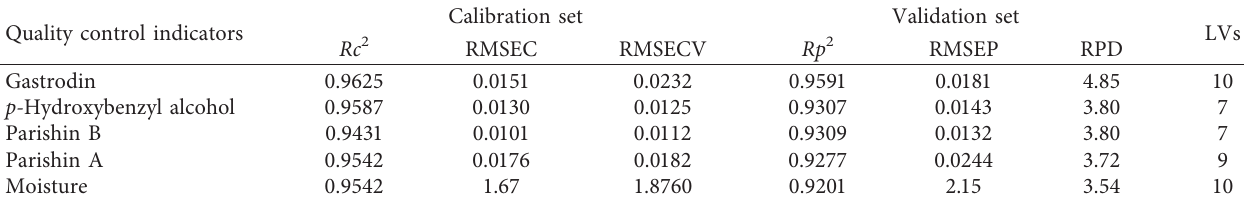
Table 6: Statistics of the optimal calibration models for five indicators.